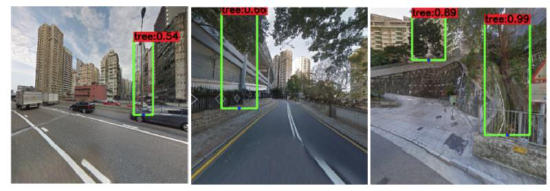
Figure 12. False tree